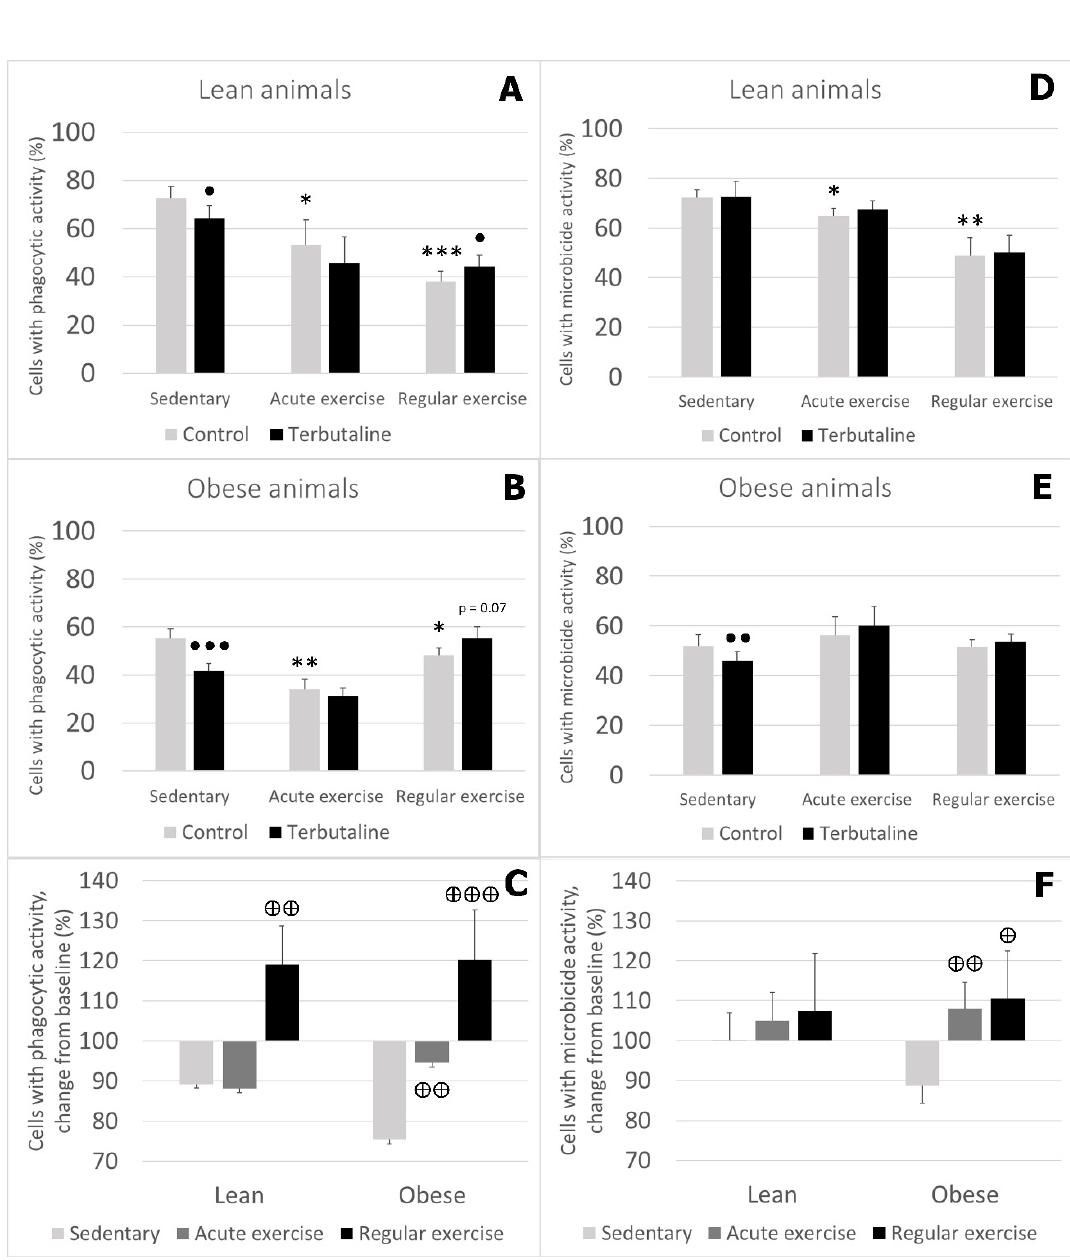
Figure 4. Effect of the β 2 adrenergic agonist terbutaline on percentage of monocytes with ( A–C ) phagocytic and ( D–F ) microbicide activity from lean ( A, D ) and obese ( B, E ) mice (sedentary, an acute and regular exercise); effect of terbutaline expressed as percentage change from baseline ( C, F ), giving “100” to control values in terbutaline absence. Columns represent mean ± SEM of independent assays performed in duplicate. * p < 0.05, ** p < 0.01, and *** p < 0.001 vs. corresponding control sedentary value; • p < 0.05, •• p < 0.01, and ••• p < 0.001 vs. corresponding control value; ⊕ p < 0.05, ⊕⊕ p < 0.01, and ⊕⊕⊕ p < 0.001 vs. corresponding sedentary